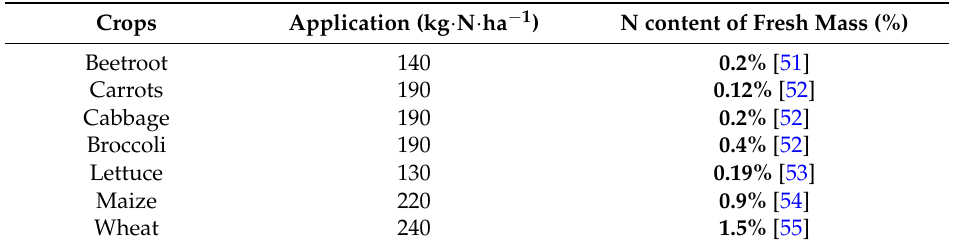
Table 2. Nitrogen application rates and nitrogen content of all selected crops used to determine surplus nitrogen